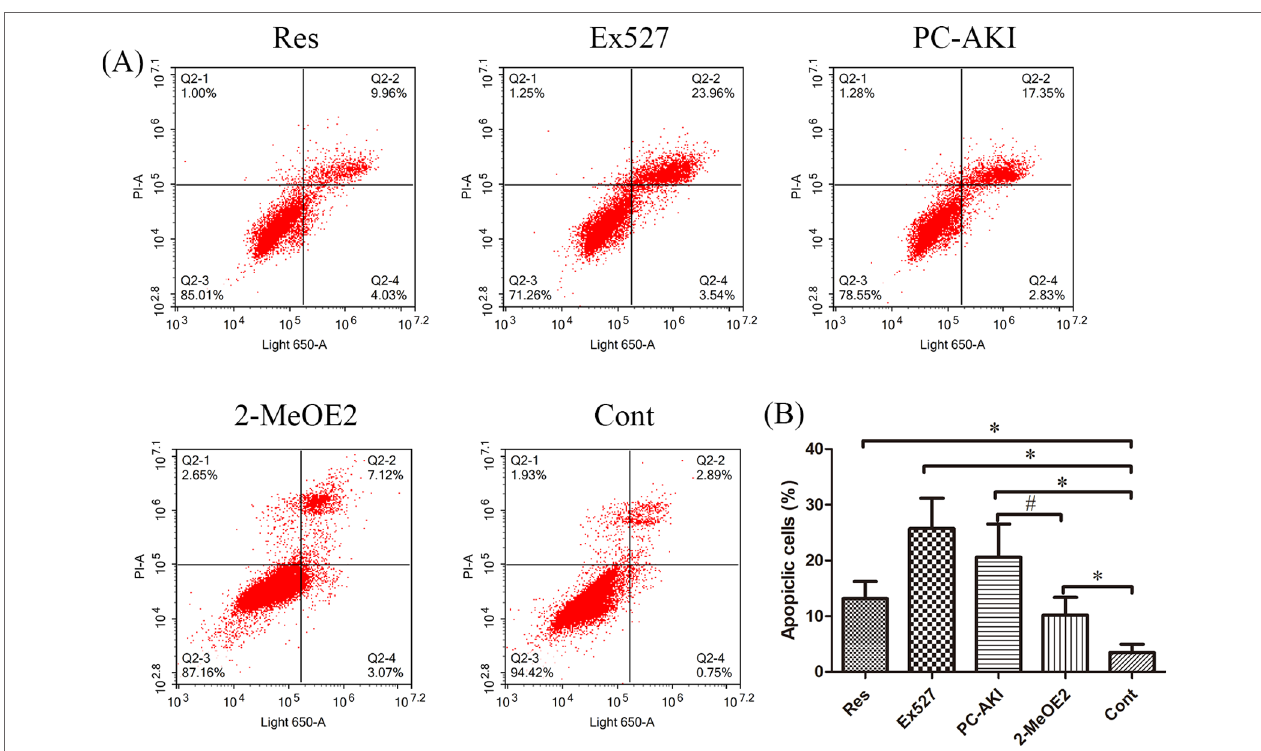
FIGURE 6 | Quantitative analysis of HK-2 cell apoptosis by flow cytometry. (A) HG-induced HK-2 cells were divided into five groups: Res, Ex527, PC–AKI, 2–MeOE2 and Cont groups. (B) Quantification of cell apoptosis in different groups. A significant increase in apoptotic cells was detected in the PC–AKI group; however, the up-regulation SIRT1 and silencing HIF-1 α could both reduce iohexol-induced cell apoptosis. * P < 0.05 vs. Cont; # P < 0.05 vs. PC–AKI. HG, high glucose; PC–AKI, post-contrast acute kidney injury; Cont, control; Res, resveratrol; SIRT1, silent information regulator l; HIF-1 α , hypoxia-inducible transcription factor-1 α ; Ex527, SIRT1 specific inhibitor; 2-MeOE2, HIF-1 α specific inhibitor 2-methoxyestradiol; LG, low glucose. Groups: Res, HG+res+iohexol; Ex527, HG+Ex527+iohexol; PC–AKI, HG+iohexol; 2-MeOE2, HG+res+2-MeOE2+iohexol; Cont, LG.